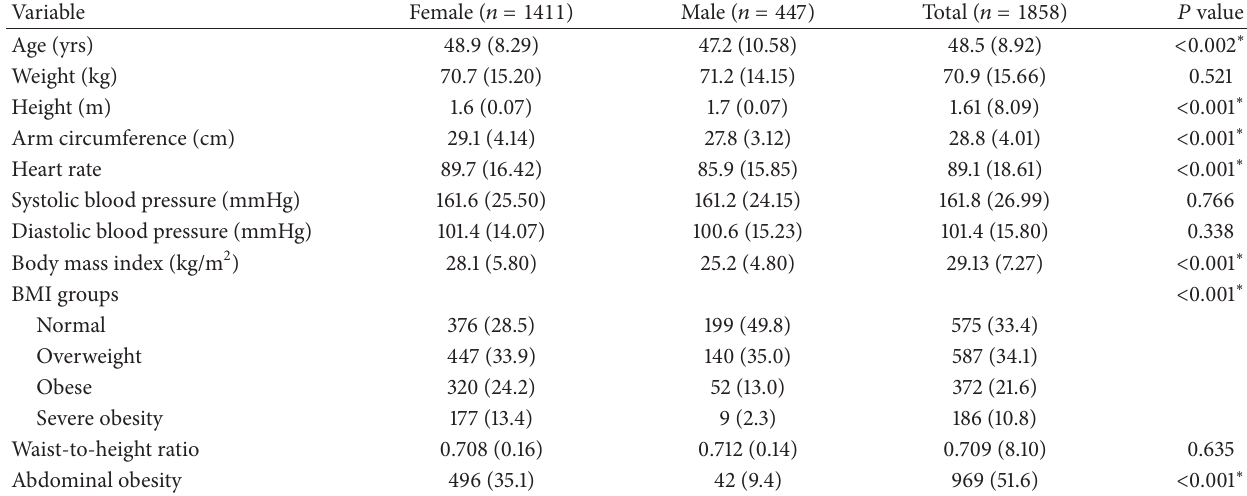
Table 1: Basic characteristics of the population.